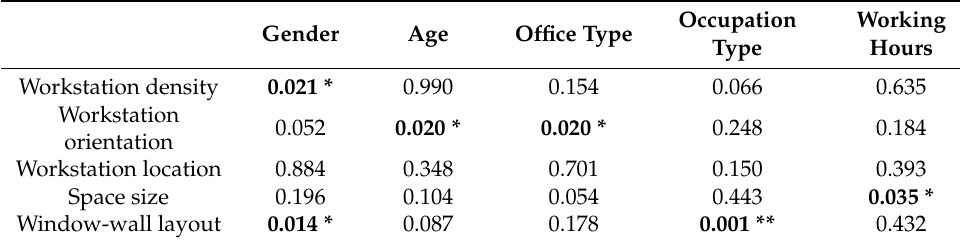
Table 7. Nonparametric analysis results ( p -value) of importance weights.